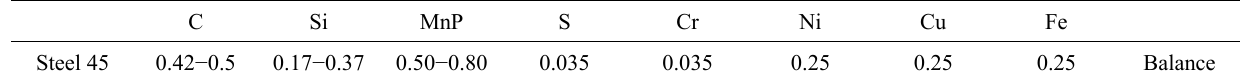
Table 1 The chemical composition of steel 45 (in